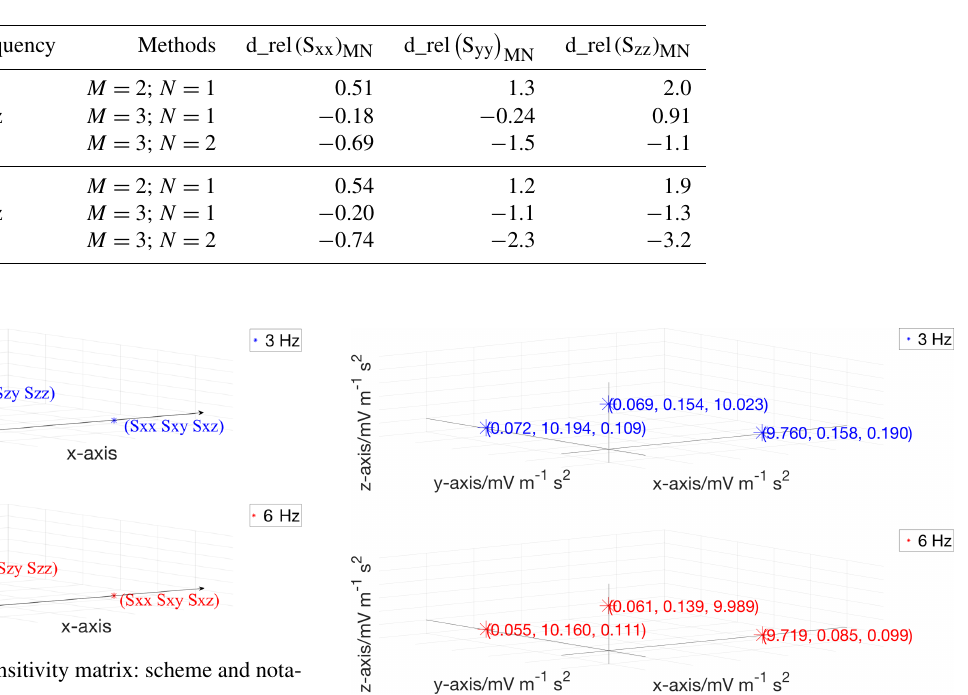
Figure 5. Angles of rotation of the accelerometers: (a) MEMS accelerometer; (b) piezo-electric accelerometer. Table 3. Piezo-electric accelerometer: comparison between methods (%).